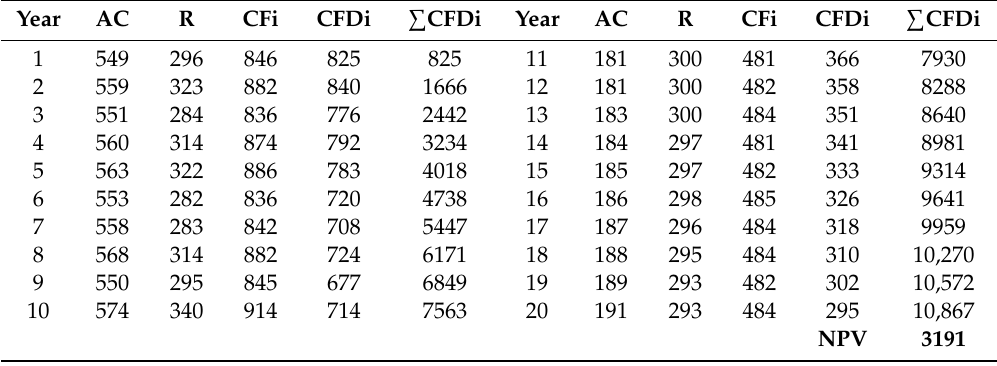
Table 13. Cash-Flow Analysis—Location 1, PV plant without Battery (cost investment, C 0 = 7676 € ).